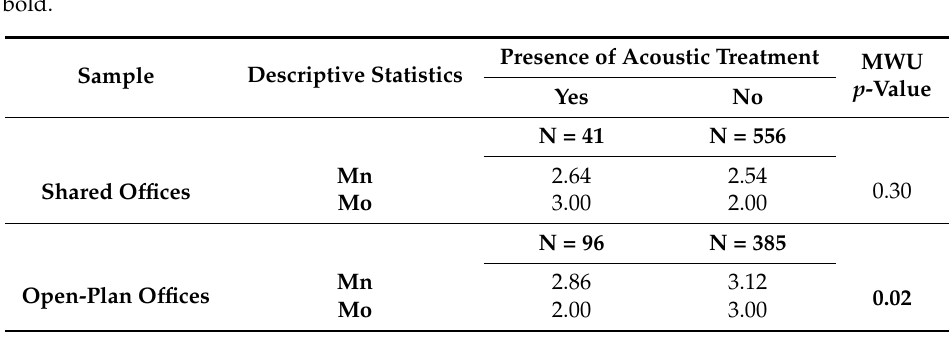
Table 6. Mean (Mn) and mode (Mo) values of the answers on noise annoyance related to the self-estimated presence of acoustic treatment in shared and open-plan offices, and two-tailed p -values of significance of the difference between the presence and absence of treatment, according to the MWU Test, for both types of offices. Any statistically significant differences, with p -values < 0.05, are reported in